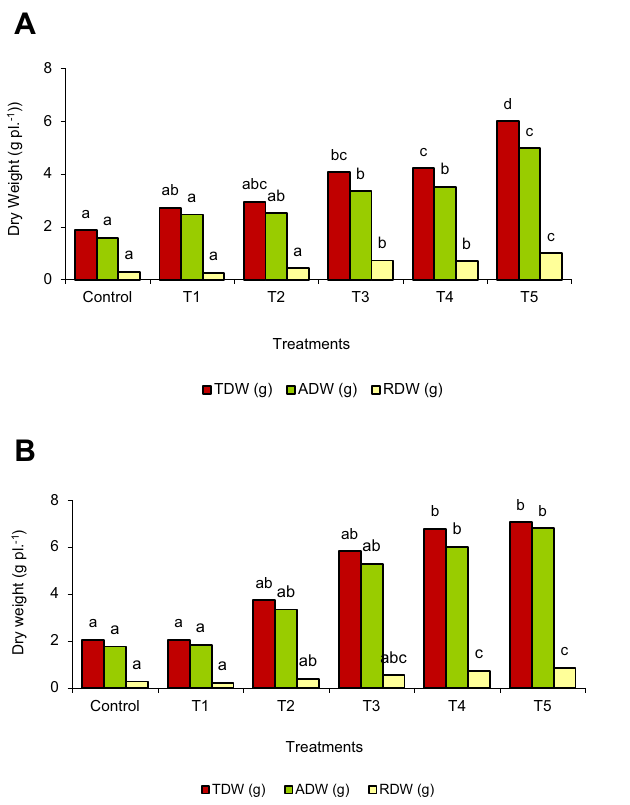
Fig. 2 Effect of different compost and mineral fertilizer dosages over the dry weight of pot-planted lettuce. a First year, b second year. TFW total fresh weight, AFW aerial fresh weight, RFW root fresh weight